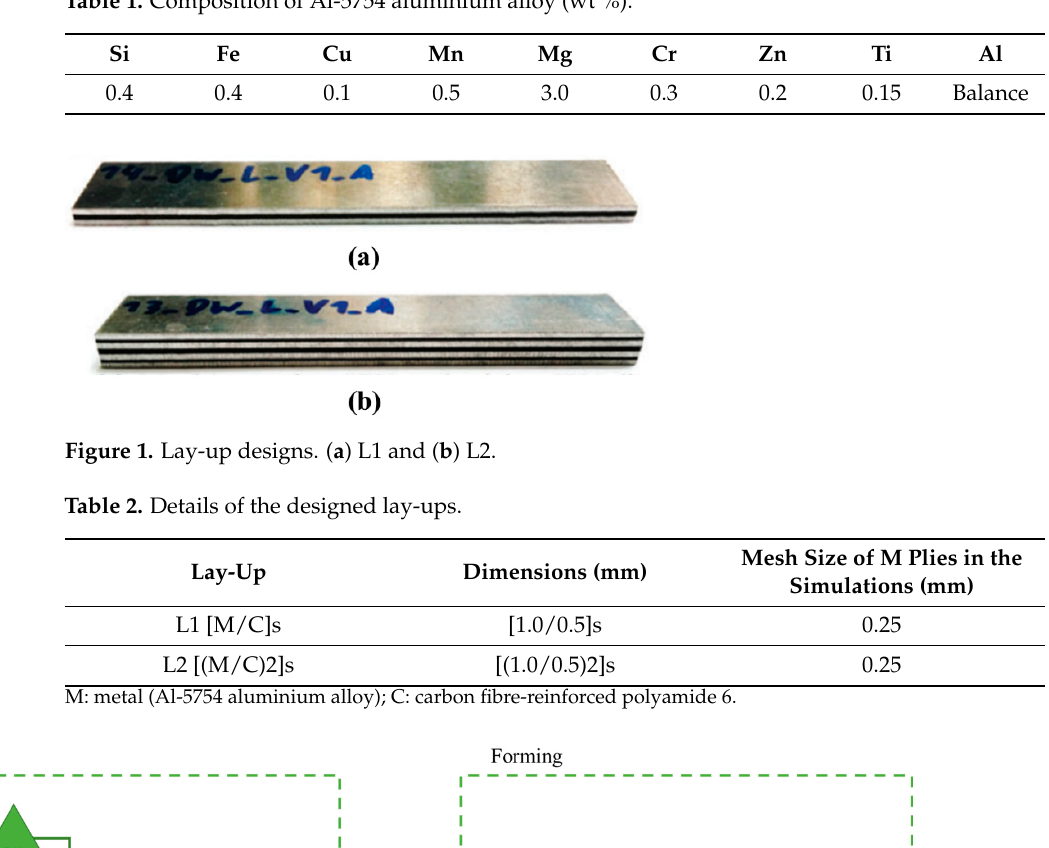
Table 1. Composition of Al-5754 aluminium alloy (wt %).